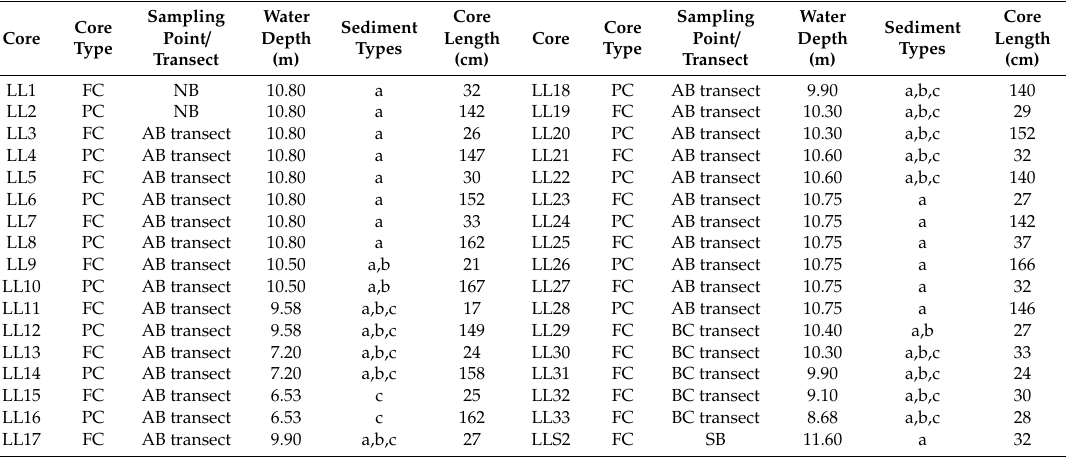
Figure 2. Photography of polished freeze core surface (left) and enlarged thin section microscopy image of the varve structure (right) from Lake Lehmilampi representing the seasonal sedimentation cycle. Light-colored clastic laminae are composed of clastic material transported into the lake during spring snowmelt flooding. Darker-colored biogenic laminae are composed of organic matter produced during the growing season. Table 1. Piston cores (PC) and freeze cores (FC) recovered from Lake Lehmilampi (AB: northwest transect, BC: southwest transect, NB: northern basin, SB: southern basin). Sediment types are characterized as varved (a), partially varved (b), and non-varved (c).